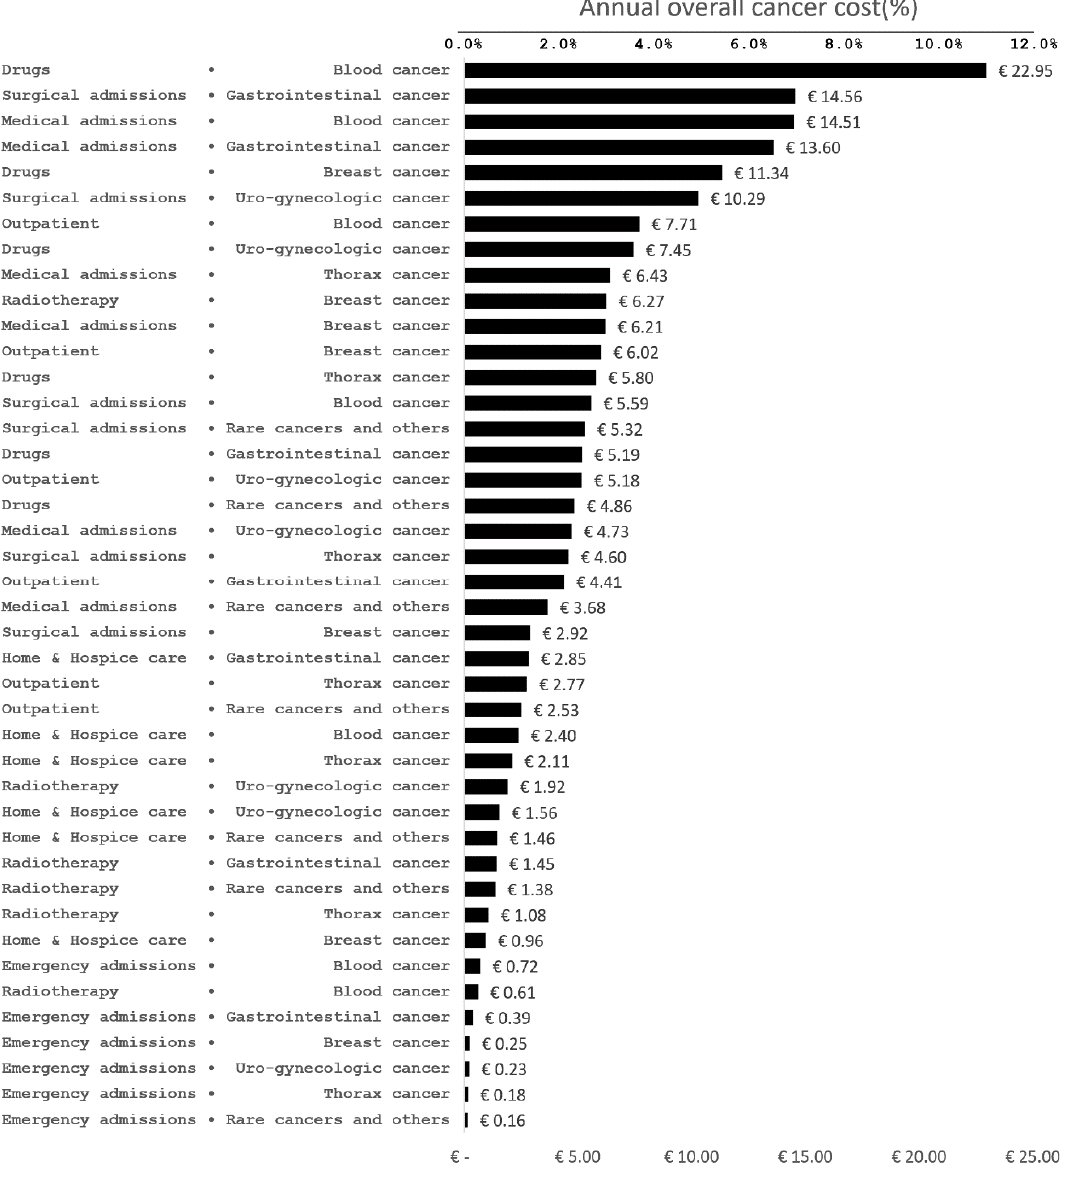
Figure 2. Annual cancer cost per capita in euros incurred for each cost item and each disease group, sorted in descending order. The horizontal bar represents the corresponding percentage of total annual cancer cost (use percent values in the upper horizontal axis as a reference) (Province of Forlì-Cesena, northern Italy, year 2016).